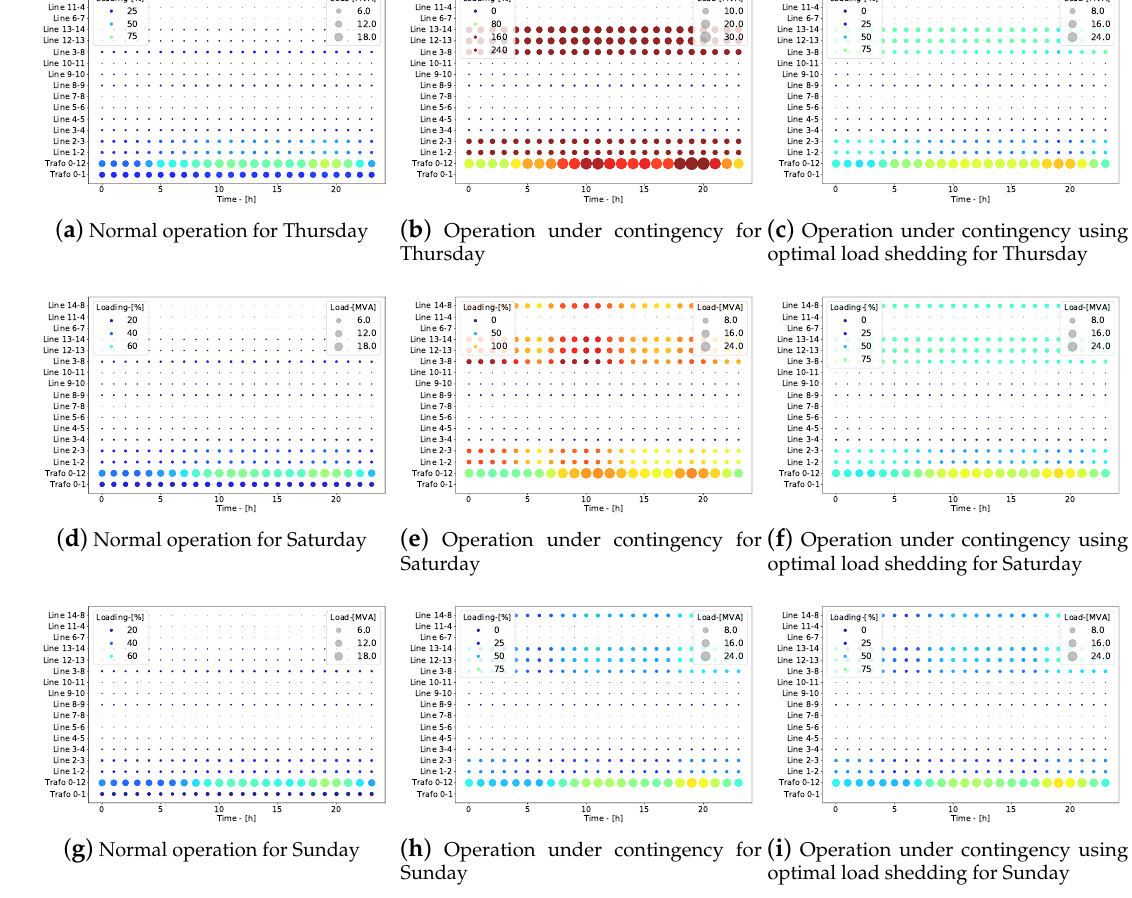
Figure 6. Loading of lines and transformers for different days and hours considering: the normal operation, a contingency when transformer Trafo 0-1 is out of service and the results of load shedding using the proposed methodology for the same